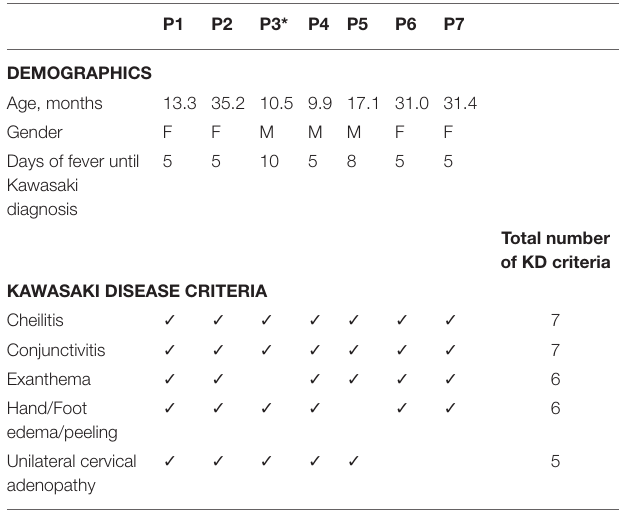
TABLE 1 | Distribution of Kawasaki disease criteria and days of fever among study